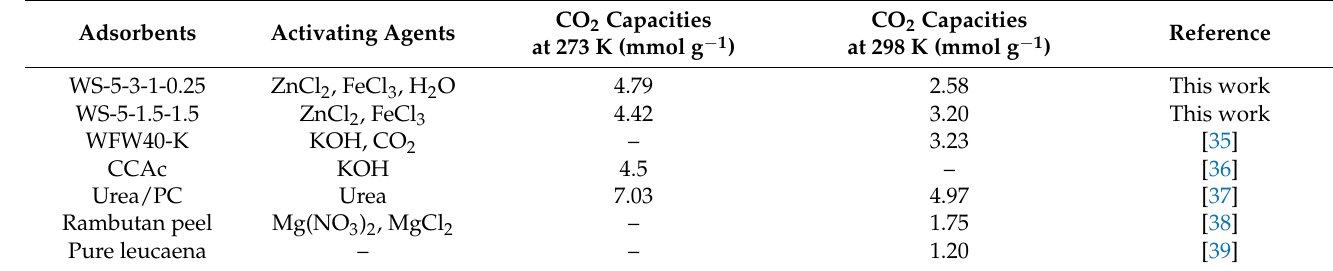
Table 3. Comparison with CO 2 adsorption from past research